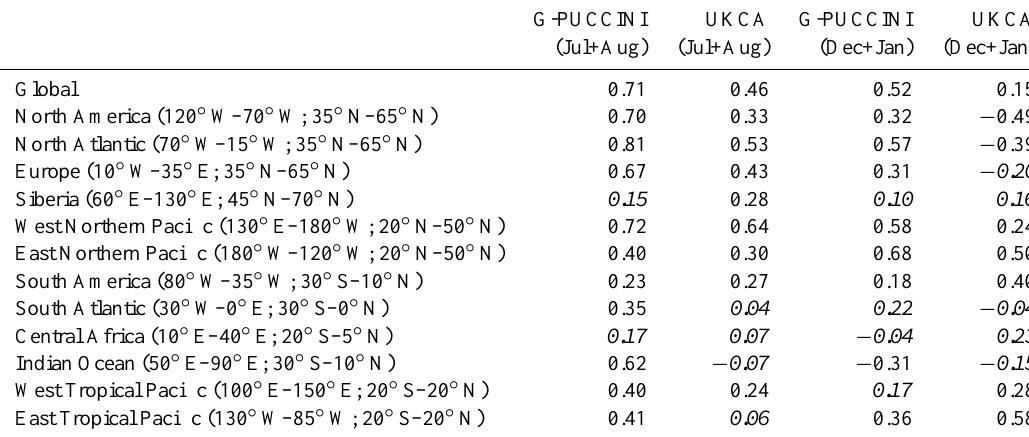
Table 1. Performance (using our C metric) in terms of capturing the O 3 -CO correlations, of the G-PUCCINI and UKCA models at various regions of the globe for two seasons (July–August and December–January). C represents the correlation coefficient between the modeled and the TES O 3 -CO correlations. The figures in italics are not statistical significant based on a Pearsons test (95% confidence interval). Note that we have avoided using regions that generally have low data availability (e.g. North Africa) based on Fig. 3a,